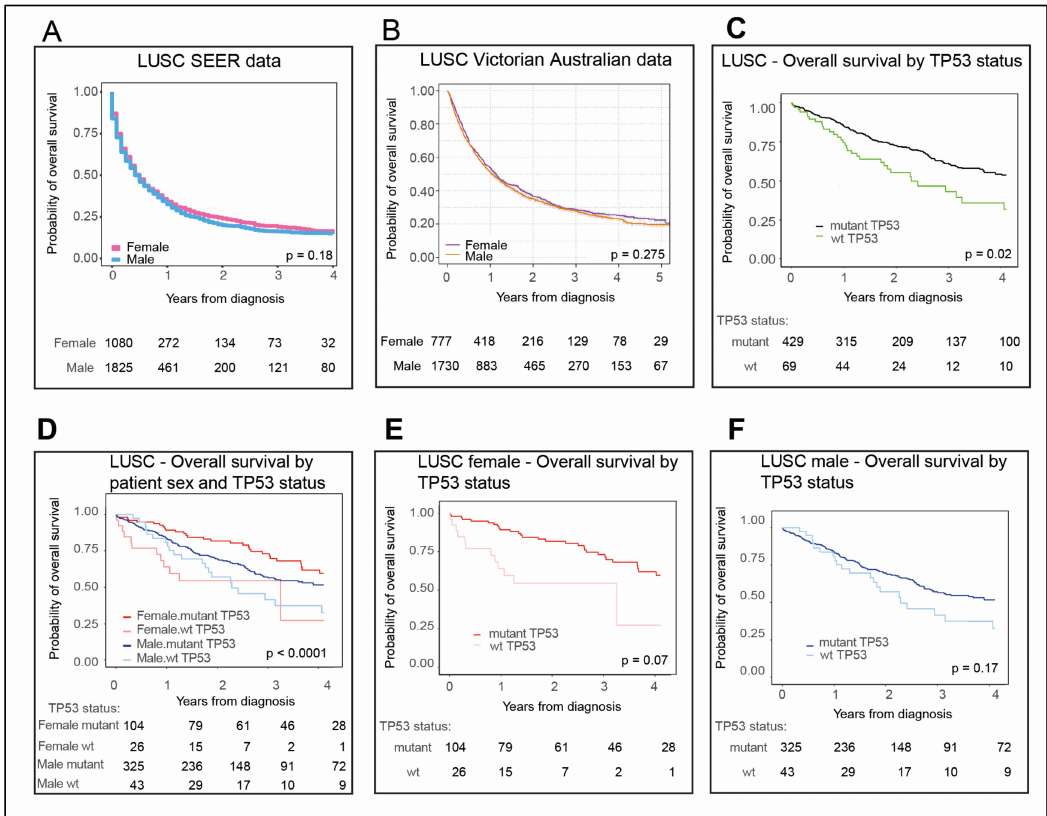
Figure 5. LUSC patient survival is longer for patients with mutant TP53 than wt TP53. LUSC overall survival data for ( A ) male (blue) and female (pink) patients in the US SEER datasets. ( B ) Male (orange) and female (purple) patients from Australian Victorian data. ( C ) LUSC patient overall survival in TCGA according to either wt p53 (green) or mutant p53 status (black), then for ( D ) females stratified for wt p53 (pink) and mutant p53 status (red) and males stratified for wt p53 (light blue) and mutant p53 status (dark blue). Also shown separately for ( E ) females and ( F ) males. The numbers of patients corresponding to each cohort are tabulated below each plot. The ‘ p ’ is the p -value for the log-rank test of di ff erences in survival time between cohorts (significant p- value < 0.05). Refer to Section 4.